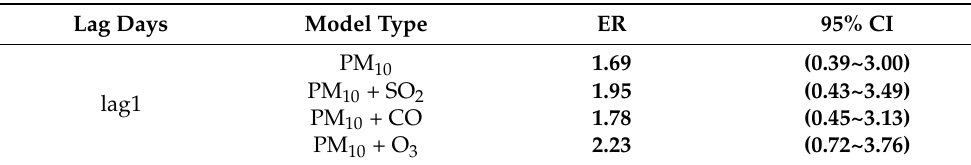
Table 4. ER change (95% CI) of CHD hospitalization associated with 10 µ g/m 3 increase of PM 10 under multiple pollutant